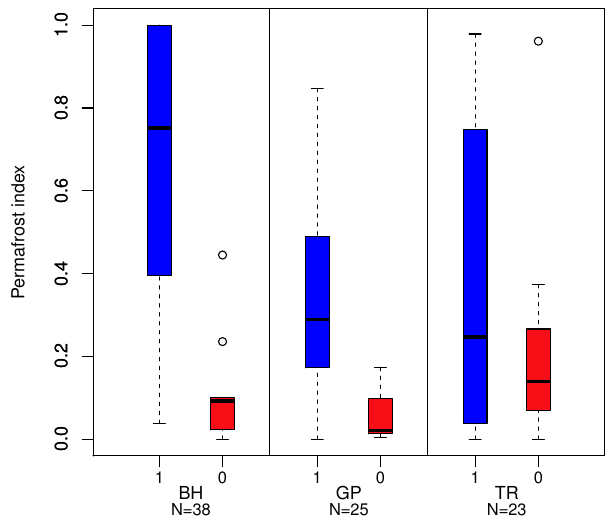
Fig. 8. Box plots showing predicted permafrost index values for the evidence types “Borehole temperatures” (BH), “Geophysical investigations” (GP) and “Trench or construction sites” (TR) for permafrost-existence (1) and permafrost-absence observations (0).